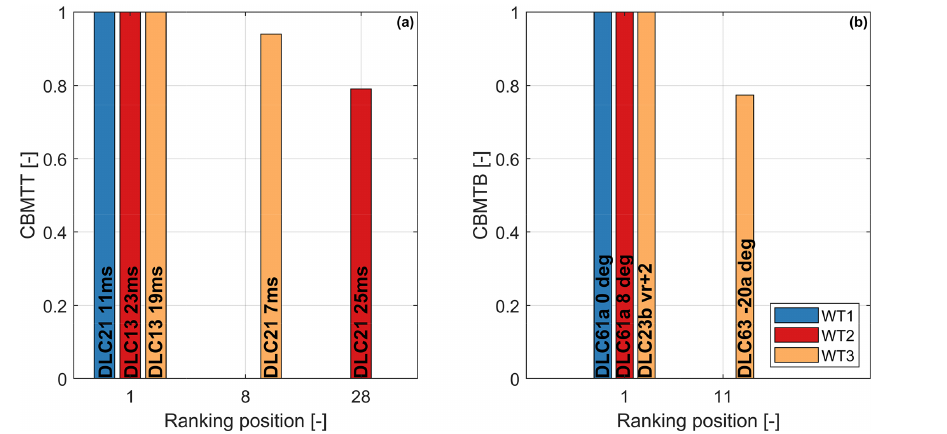
Figure 3. Ranking of normalized combined bending moment at tower top (CBMTT) (a) and tower bottom (CBMTB) (b) , for the three turbines. Only the leading and first blocking DLCs are shown.